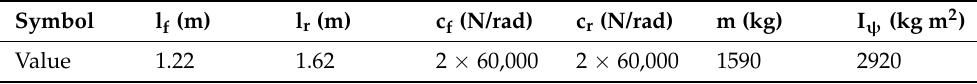
Table 2. The realistic data of the